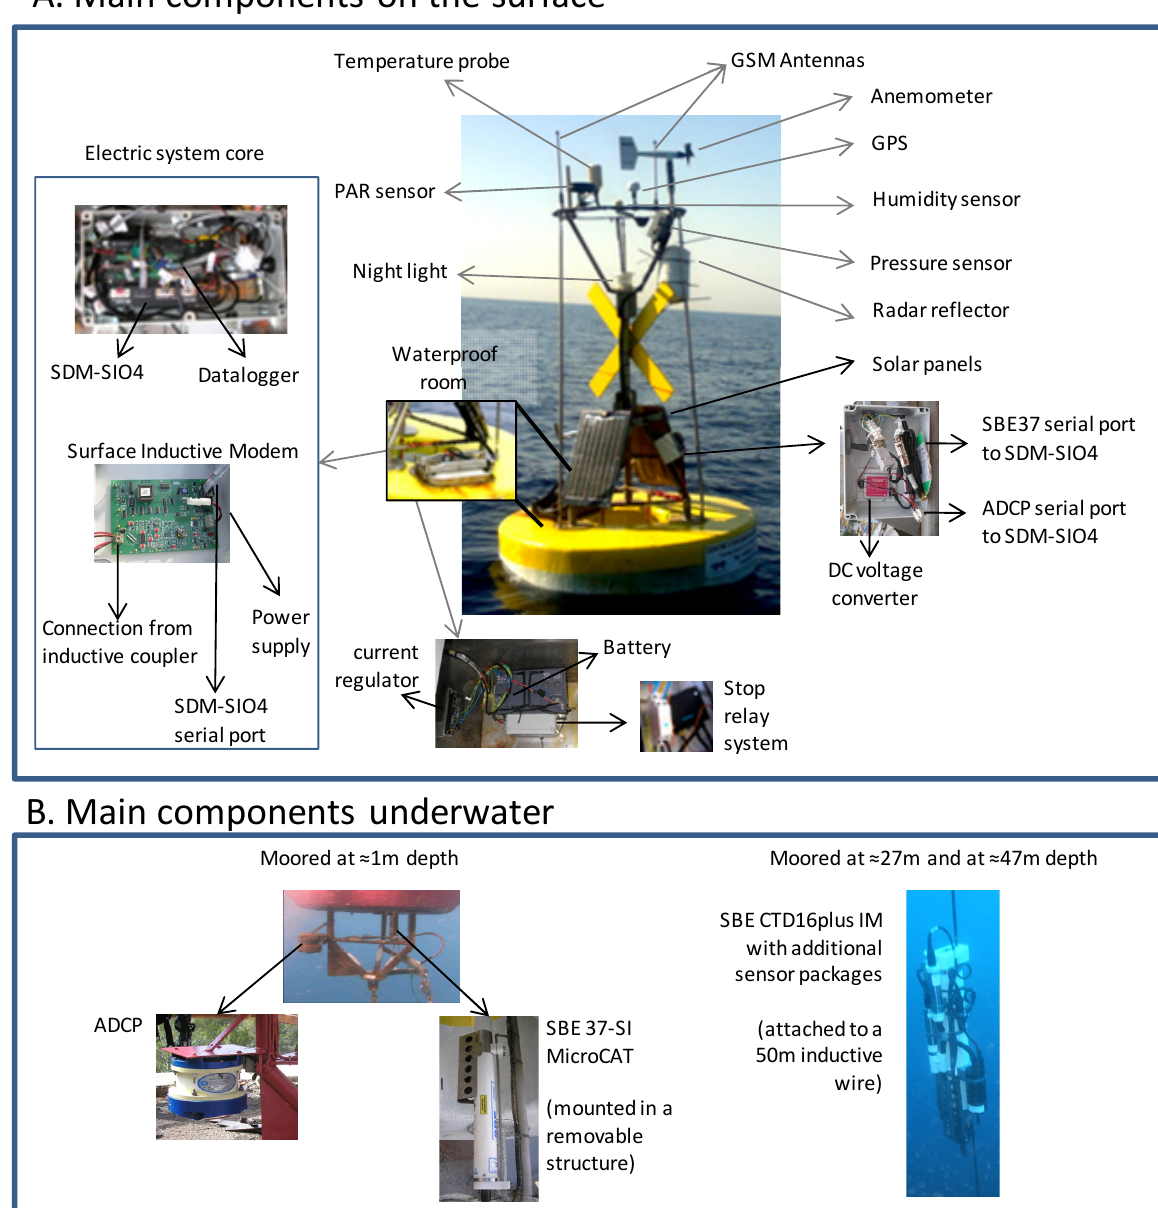
Figure 2. The OOCS key components in ( A ) the surface equipment and ( B ) underwater for the multisensor coordinated atmospheric and oceanographic monitoring (see Table 1 for details on installed